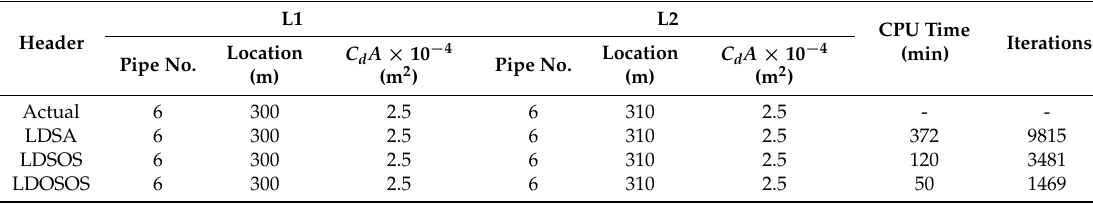
Table 3. Actual leak information and predicted results from three approaches for S1.